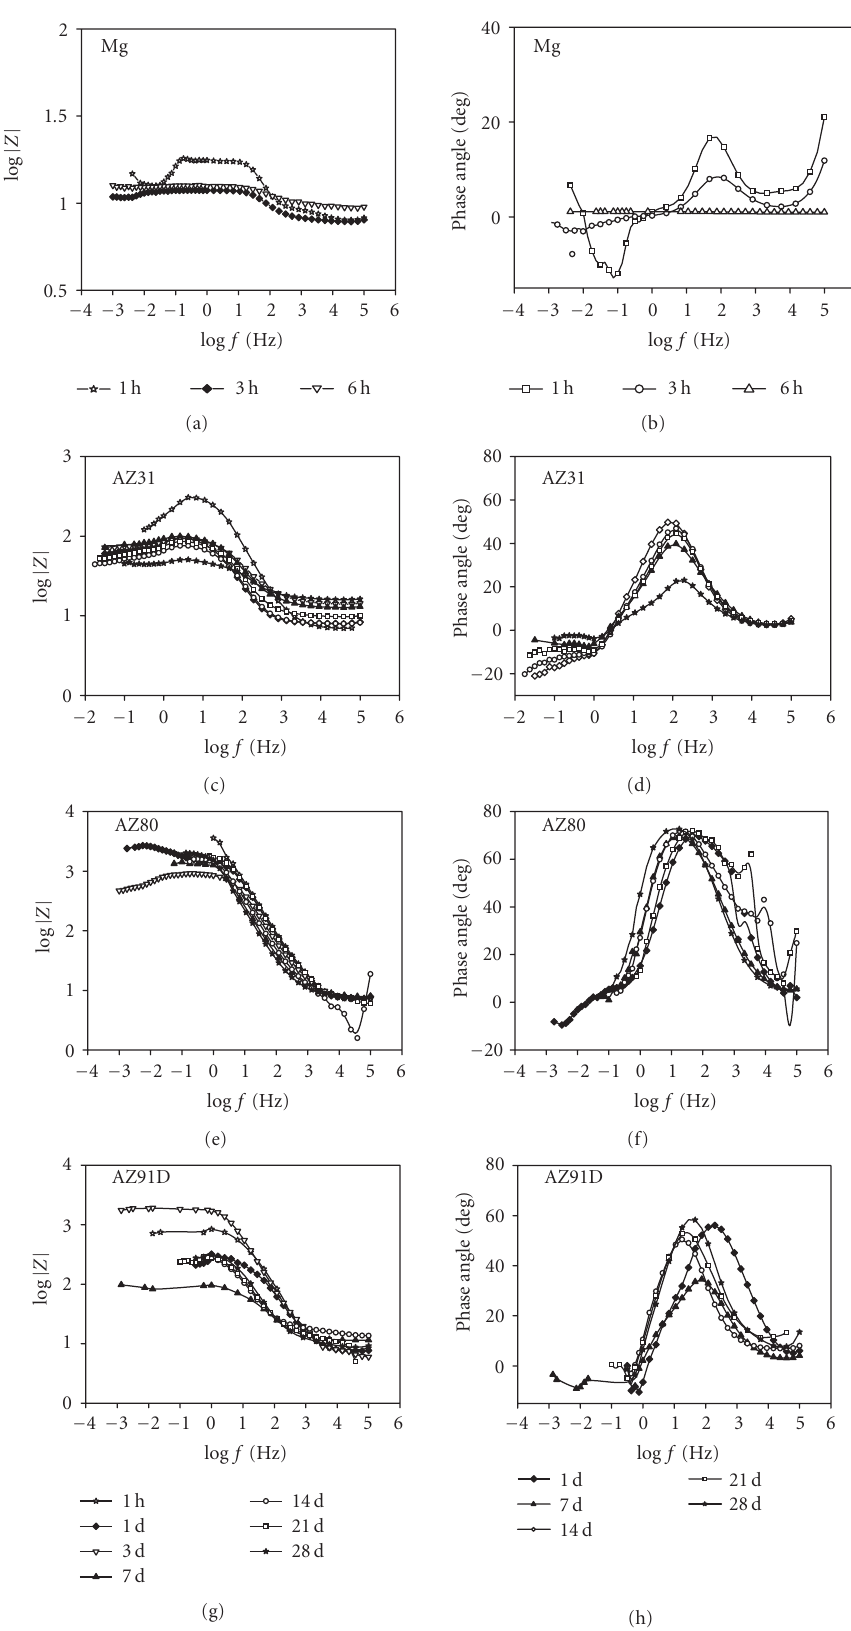
Figure 1: Impedance Bode diagrams as a function of immersion time in 3.5wt.% NaCl solution for tested specimens of (a) Mg metal and AZ31 alloy and (b) AZ80 and AZ91D